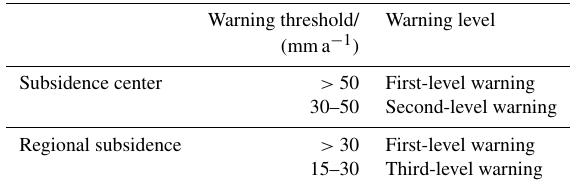
Table 1. Classification of land subsidence warning